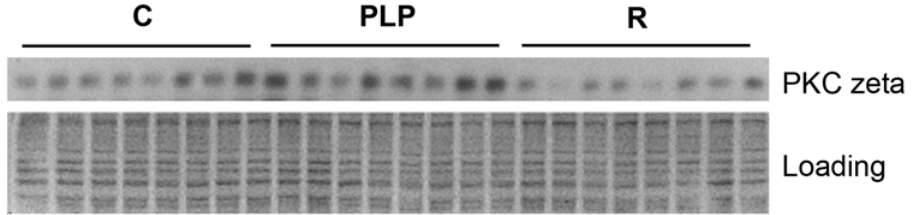
Figure 4. Representative Western blot for PKC f in muscle. Protein levels of insulin signalling molecules in muscle of control (C), postnatal low protein (PLP) and recuperated (R) were analysed by Western blotting using appropriate antibodies. Shown is a representative blot for PKC f . 25 m g of protein were used and equal loading was confirmed by Coomassie blue staining. Densitometry analysis data are summarized in Table 1.